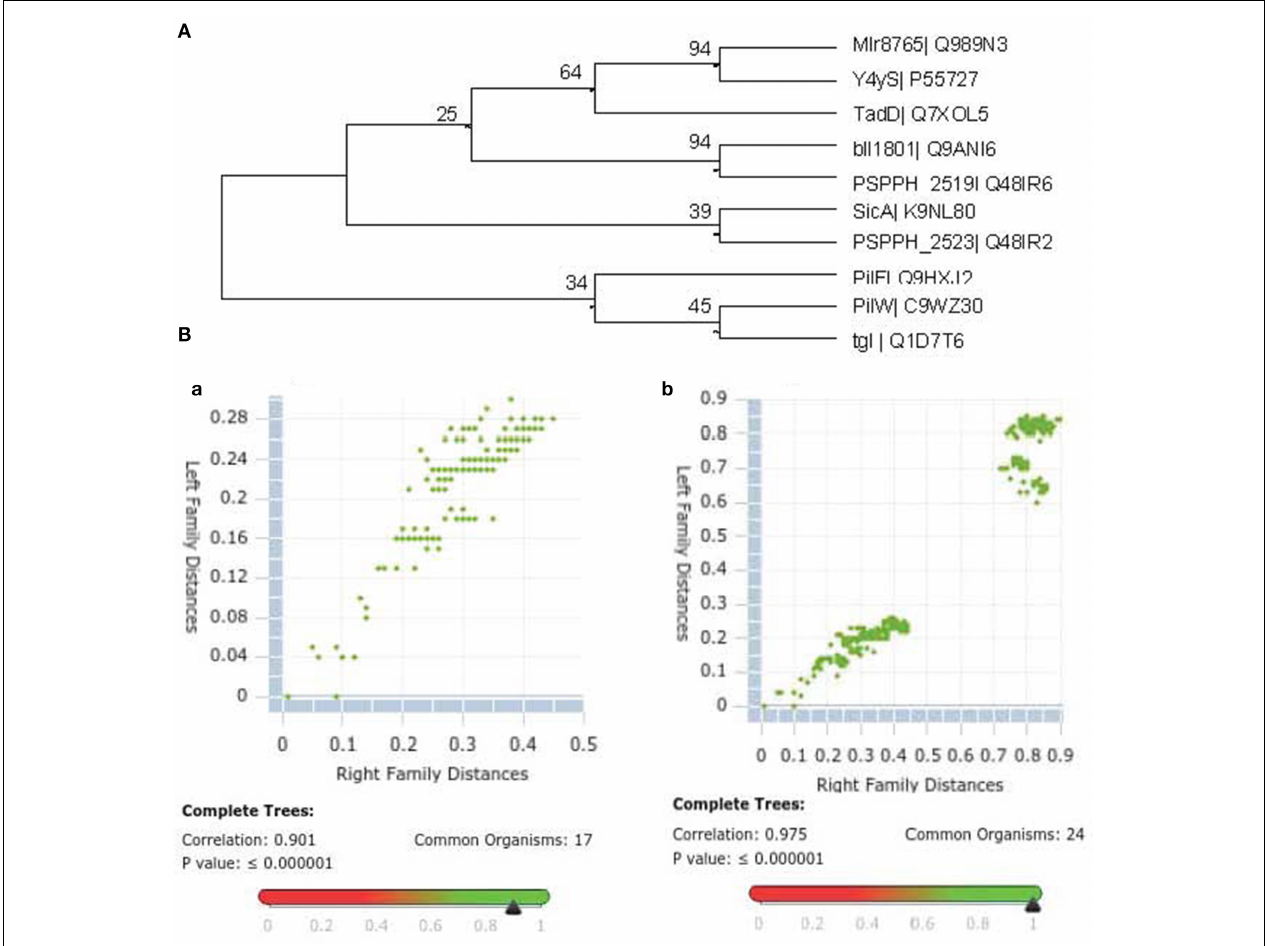
FIGURE 5 | (A) Phylogenetic analysis of bacterial TPR proteins involved in secretion systems. Bacterial TPR proteins described in the text were subjected to a phylogenetic analysis as indicated in Materials and Methods. A cladogram could be constructed only with the proteins indicated next to each branch arm. The percentages of replicate trees in which the associated taxa clustered together in the bootstrap test are shown next to the branches. (B) Inter-protein distances of two